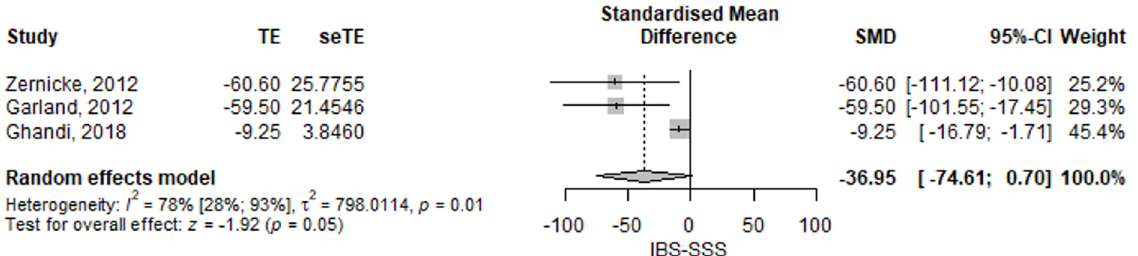
Figure 2. Irritable bowel syndrome symptom score—standardized mean difference comparison between mindfulness intervention and control. IBS-SSS, irritable bowel syndrome symptom score; SMD, standardized mean difference; TE, treatment effect as SMD; seTE, standard error of the treatment effect; CI, confidence interval [15,17,20].